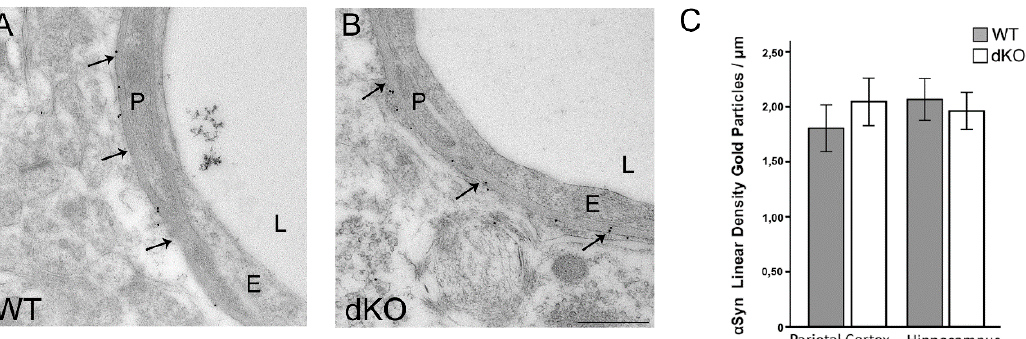
Figure 2. Immunogold analysis of perivascular α -syntrophin expression in WT and Cx43 / 30 dKO mice. ( A , B ) Electron micrographs of hippocampus from WT and dKO mice shows that α -syntrophin immunogold labeling is concentrated in the perivascular membrane domain (arrows). ( C ) Quantitative analysis of α -syntrophin immunogold labeling in parietal cortex and hippocampus of Cx43 / 30 dKO and WT. No significant di ff erence was observed between the genotypes. E; endothelial cells, P; pericyte, L; vessel lumen. Scale bar: 500 nm. * significant di ff erence according to ANOVA with Bonferroni’s post hoc test, n = 5 for each genotype; error bars indicate SEM. p < 0.05 .